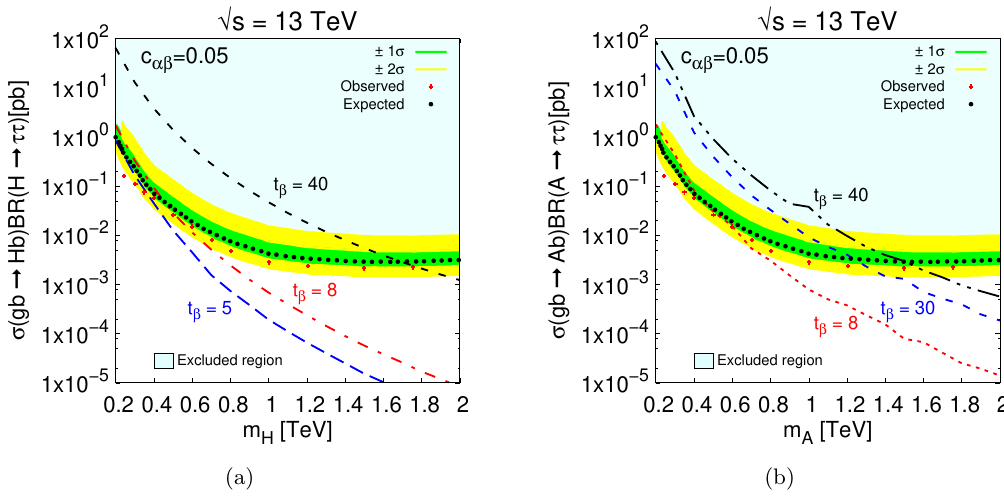
Figure 4 . The observed and expected at 95% CL upper limits on the production cross section times ditau branching ratio for a scalar boson produced via b -associated production as a function of (a) the -even mass for t (cid:12) =5, 8, 40 and (b) the CP c (cid:11)(cid:12) = 0 :